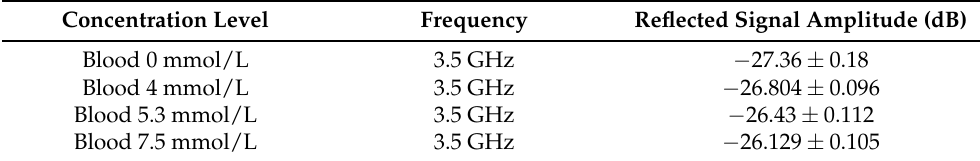
Table 4. Reflected signal amplitude values for different glucose concentrations.